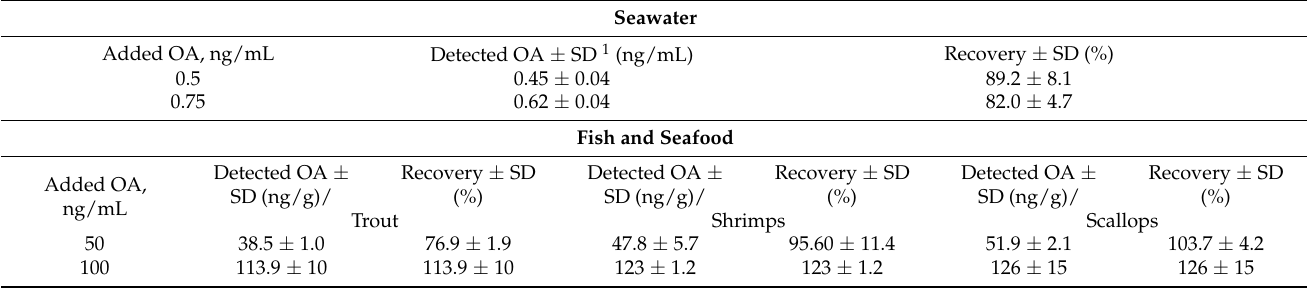
Table 1. Recoveries of OA from seawater, fish, and seafood ( n = 3).